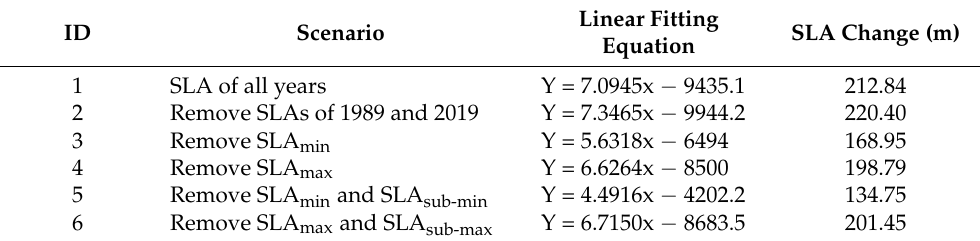
Table 5. Under six different scenarios, SLA changes in Qilian Mountains from 1989 to